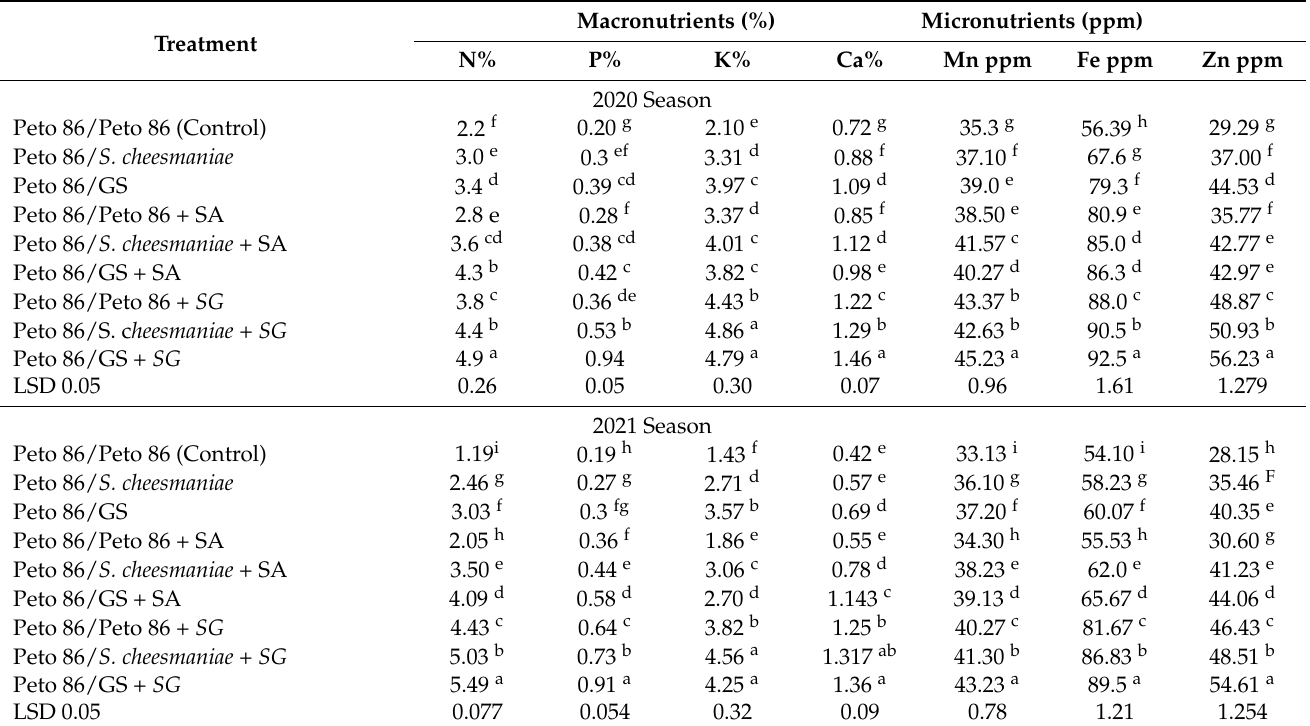
Table 3. Effects of grafting, seed priming with shikimic acid (SA), and colonisation with S. griseus (SG) on nutrient content of tomato leaves during 2020 and 2021